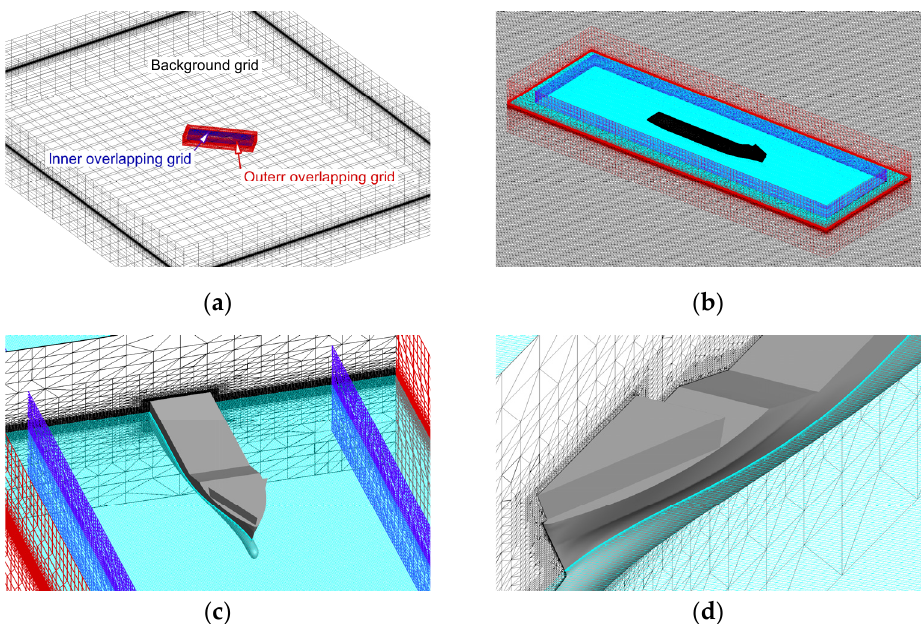
Figure 2. Overset computational mesh. ( a ) Global view of the computational domain; ( b ) global view of the inner computational domain; ( c ) close-up view of the overlapping inner domain; ( d ) close-up view of the inner mesh around the hull.